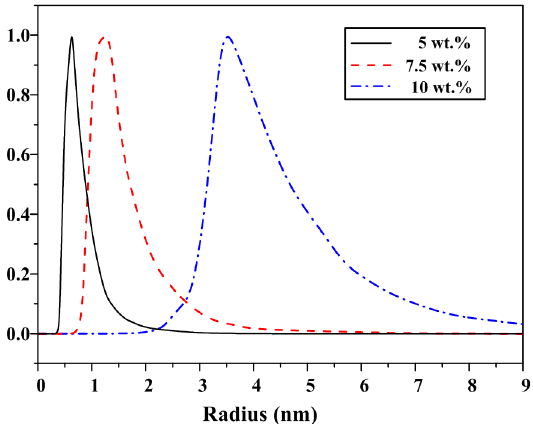
Figure 2. Radius distribution curve of micro water droplets in different polishing fluids.